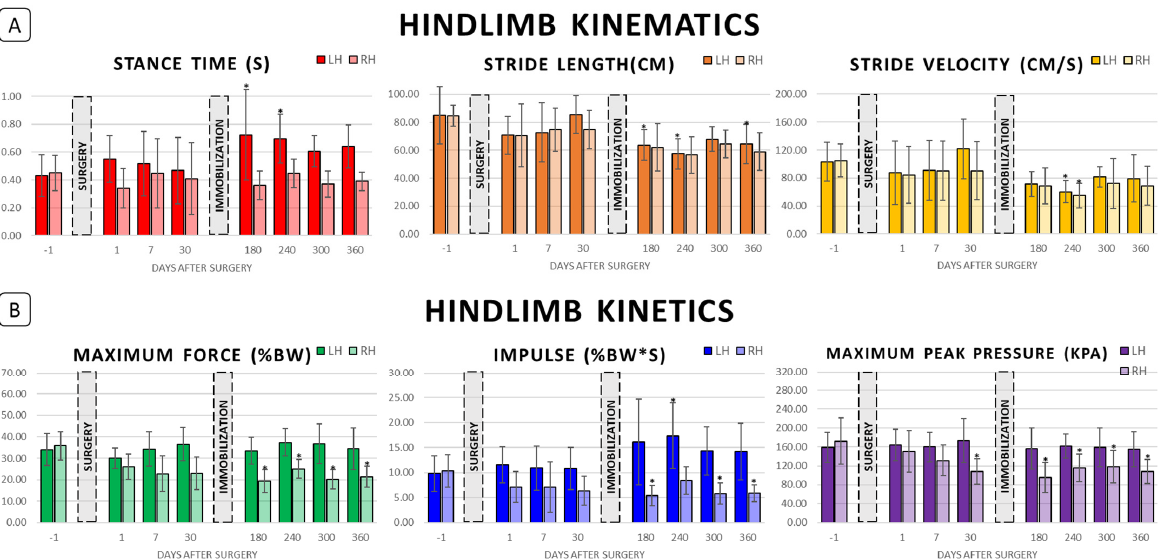
Figure 3. Hindlimb biomechanics following right hindlimb tibial segmental defect locking plate stabilization and following right hindlimb cast immobilization. ( A ) Hindlimb kinematics preopera- tively (Day − 1) and postoperatively at Days 1, 7, 30, 180, 240, 300, and 360. ( B ) Hindlimb kinetics at the same timepoints. “*” represents value significantly different from the respective preoperative baseline in pairwise comparison; p < 0.05.